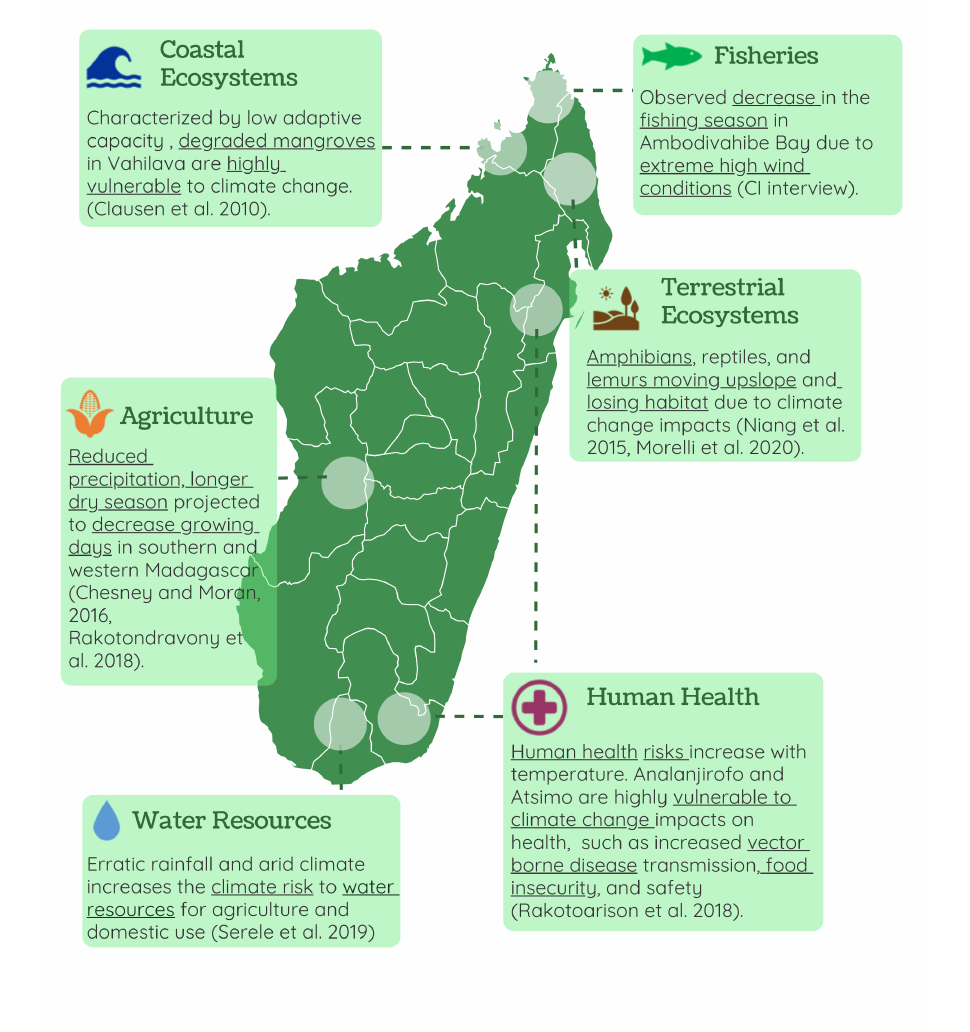
Fig. 1 . Specific examples of observed and projected climate change risk to water resources, agriculture, human health, coastal ecosystems, fisheries, and terrestrial ecosystems sectors in